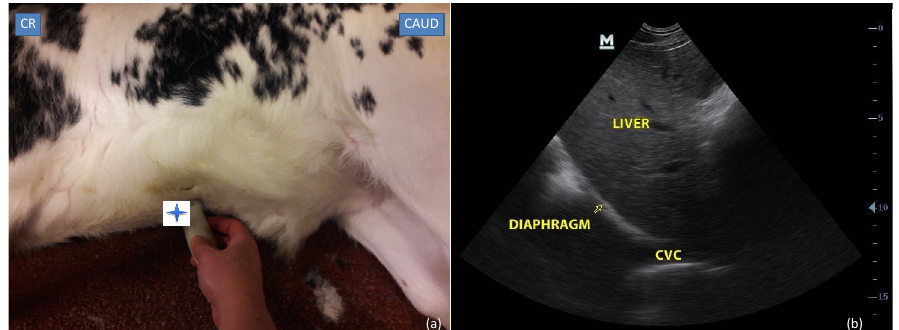
Figure 1. Subxiphoid site: ( a ) probe placement site and ( b ) ultrasonographic view of caudal vena cava (CVC) crossing the diaphragm (Yellow arrow). The blue star shows the position of the probe marker. CR: cranial; CAUD: caudal.